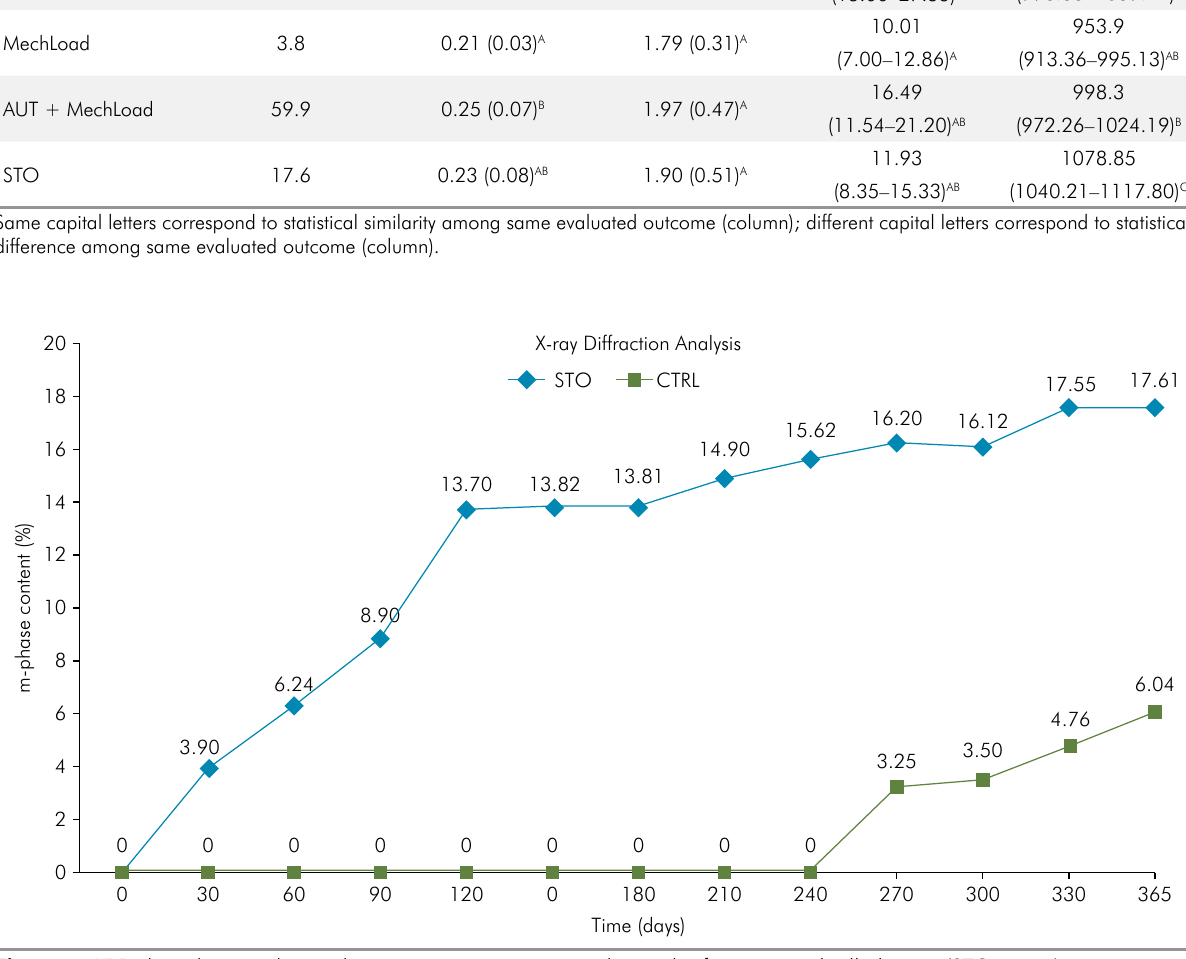
Figure 1. XRD data showing the m-phase content increase in each month of storage in distilled water (STO group) in comparison to specimens kept on ambient conditions (sealed dry vessel at room